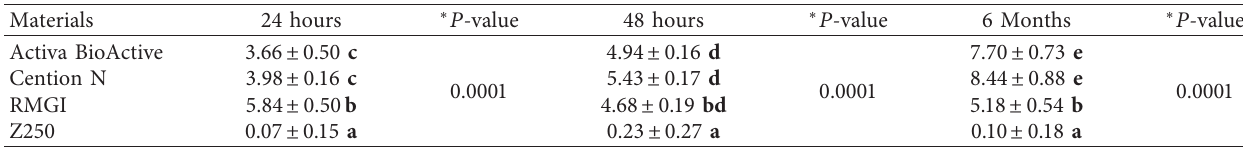
Table 2: Mean (and standard deviation) amount of phosphate ions released ( µ g/cm 2 ) from restorative materials following pH reduction from 6.8 to 4 at different time points of